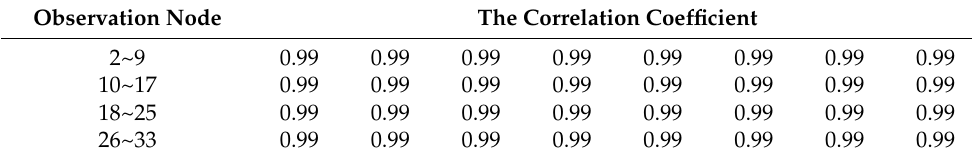
Figure 9. The CPD curve of the voltage change of node 12. Table 4. The correlation coefficients.